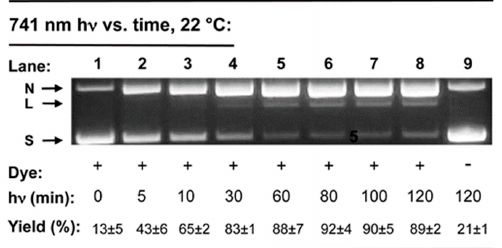
Figure 3. A representative agarose gel showing photo-cleavage as a function of time for 38 µM bp pUC19 DNA in 10 mM sodium phosphate buffer pH 7.0 (22 °C). Individual reactions in the presence and absence of 24 µM of dye 4 were irradiated with a 741-nm LED lamp (0.3 W/cm 2 ; spectral output 707–759 nm) for time intervals ranging from 0 to 120 min. Data points are averaged over 2–3 trials. Errors represent standard deviation. Abbreviations: N, nicked; S, supercoiled.